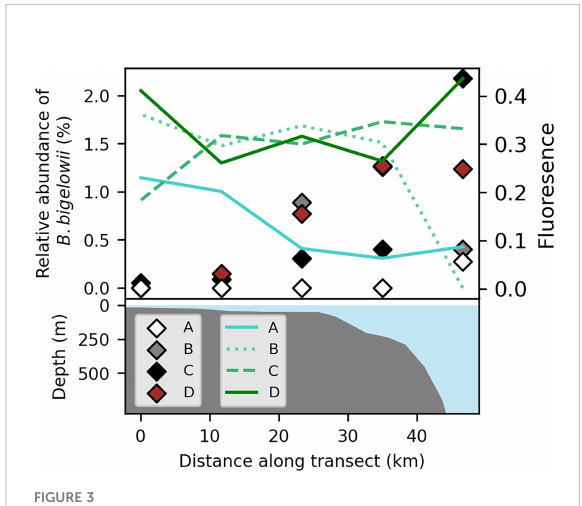
FIGURE 3 Chlorophyll a relative fl uorescence (lines) and relative abundance of B. bigelowii 18s rRNA sequence reads (diamonds) among all eukaryotic phytoplankton (haptophytes, dino fl agellates, diatoms) at the onset of the upwelling event (August 30-31, A), during the event (September 1-2, B), after the event (September 3-4, C), and at the onset of a second, weaker upwelling event (September 5, D; top panel), aligned with bathymetry from the International Bathymetric Chart of the Arctic Ocean version 3.0 (bottom panel; Jakobsson et al., 2012). Blue coloration (bottom panel) indicates water column